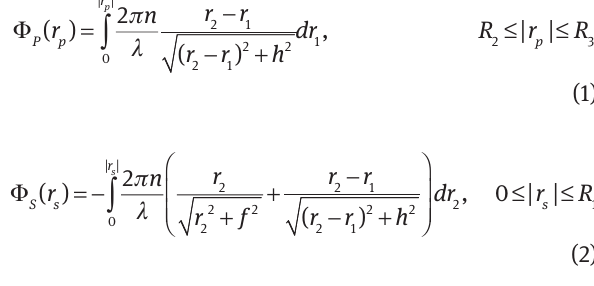
= 240 μ m, R = 250 μ m, 1 2